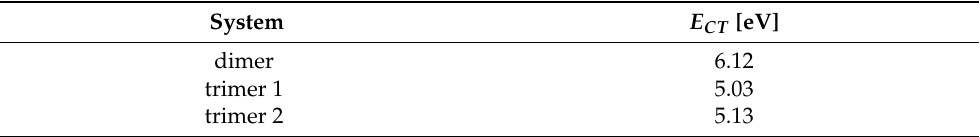
Table 1. Charge transfer energies ( E CT ) calculated for the benzo[h]quinoline-2-methylresorcinol complexes shown in Figure